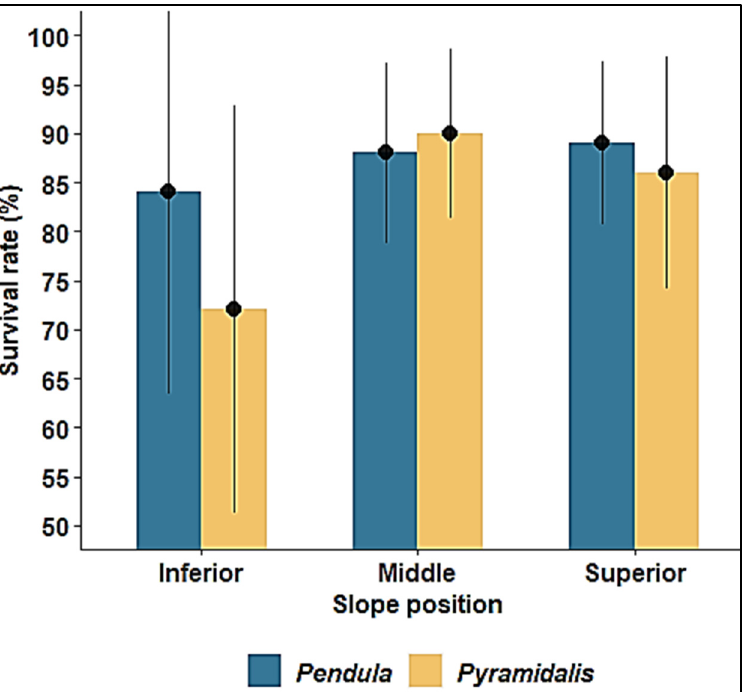
Figure 9. The influence of the slope position on the survival of the two spruce variety. The black vertical lines represent the standard deviation.